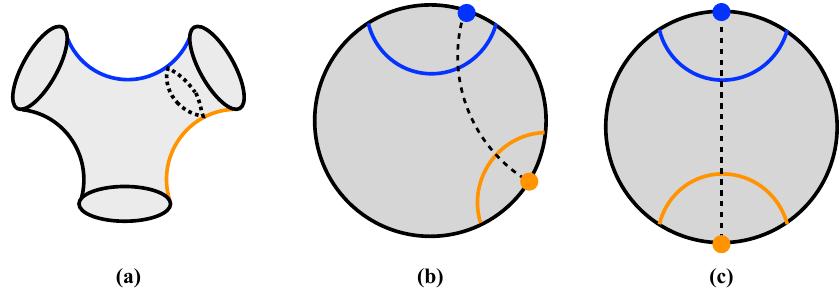
Figure 8 . (a) We would like to compute the length of the closed geodesic (dotted line) in the wormhole geometry. (b) We can relate this calculation to the one in the Poincare disk. There are two fixed points of our geodesics and these correspond to the fixed points of a group element γ . (c) We can diagonalize γ or equivalently we can move these two points to antipodal points. Then, our calculation of closed geodesics reduce to the calculation of the Tr γ